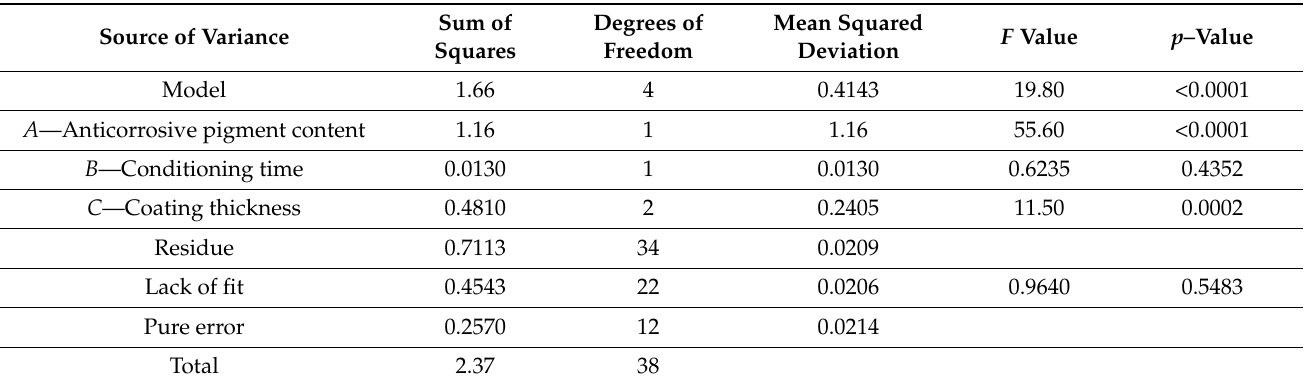
Table 9. Analysis of variance for the regression model for notch corrosion after 480 h in the salt-spray test